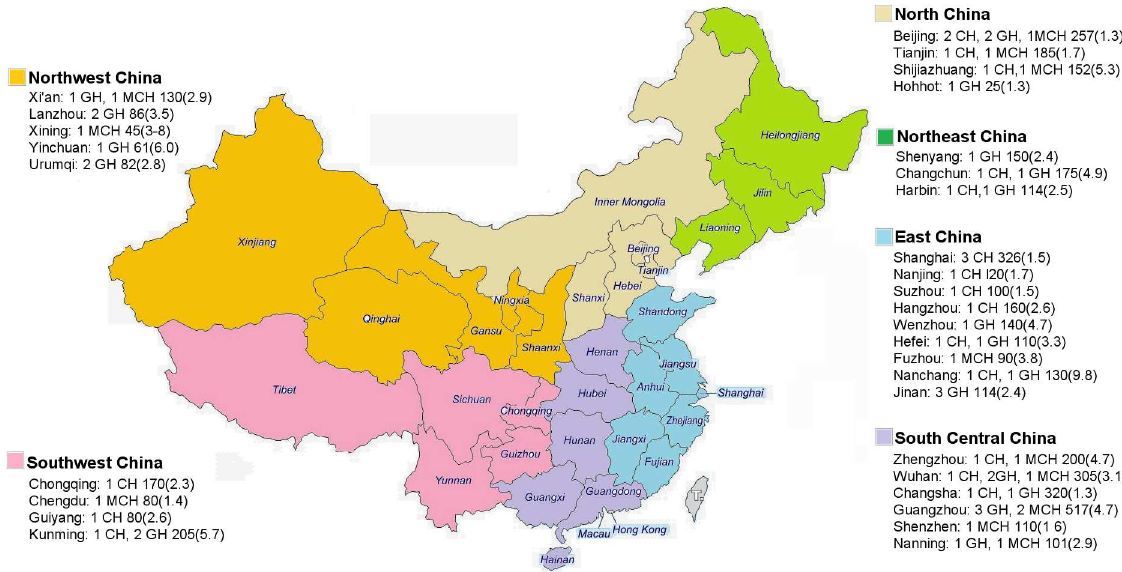
Fig 1. Distribution of 61 surveyednewborn units in China. Sixty-one surveyednewbornunits were from Class A level III provincial or ministerial affiliated hospitals,distributedin 31 cities of 28 provincial districts amongsix geographical regions in mainland China. The units were from child hospital (CH), generalhospital(GH), and maternal and child hospital (MCH). The city names, hospital types, newbornbeds, and newbornbed-population ratios (number in the brackets, for every 100,000population) were marked respectively.The adaptedmap is for illustrative purposes only, originallyfrom the free maps website (http://www.d- maps.com/carte.php?num_car=11572&lang=en).